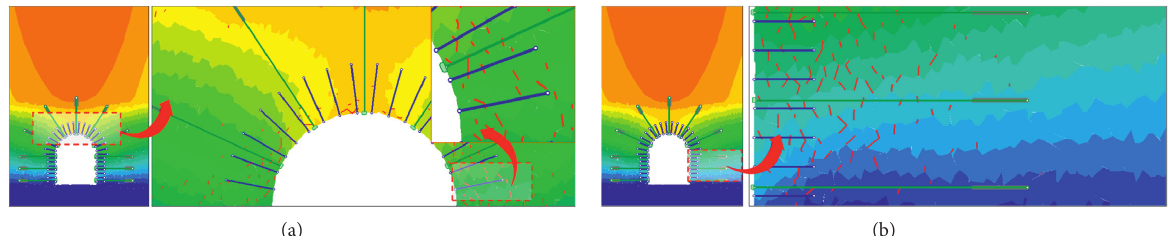
Figure 14: The crack development characteristics of surrounding rock: (a) cracks in the dome and (b) cracks in the ribs.